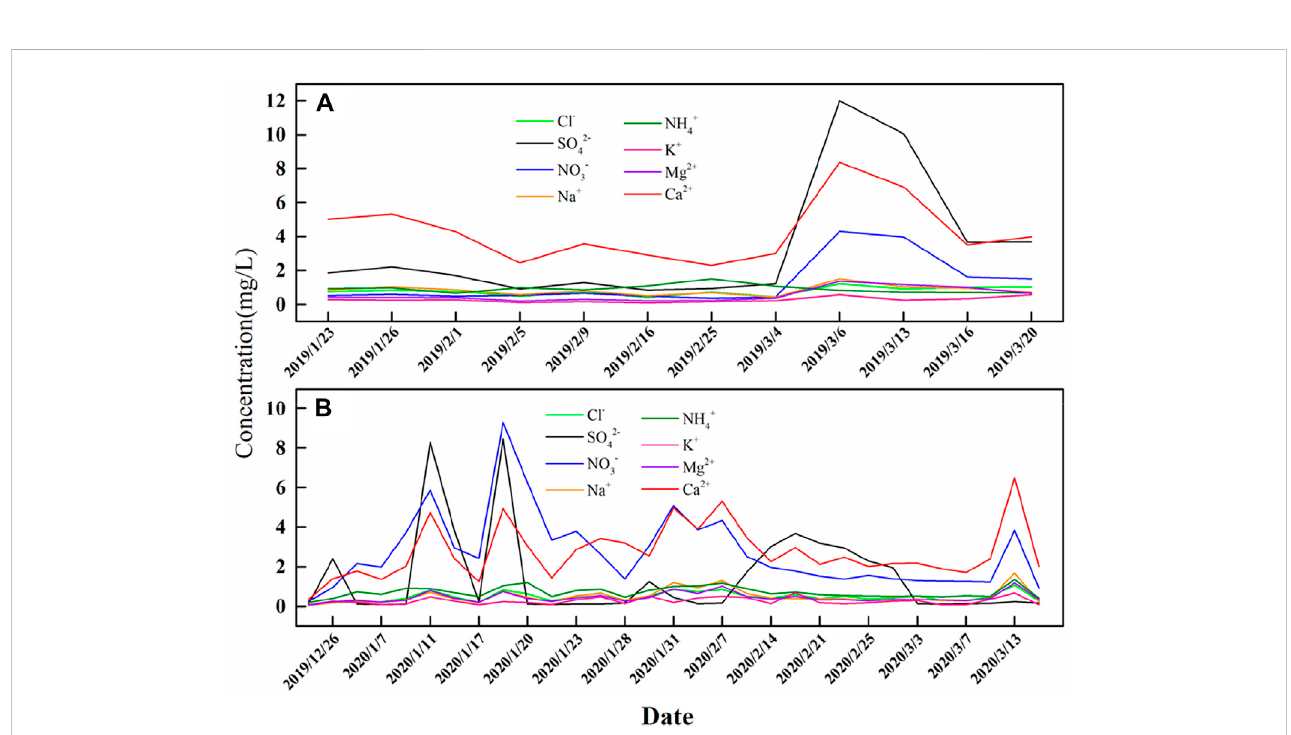
FIGURE 8 Temporal variation of several major inorganic ions in Altay region, where (A) is in 2018/2019, and (B) is in